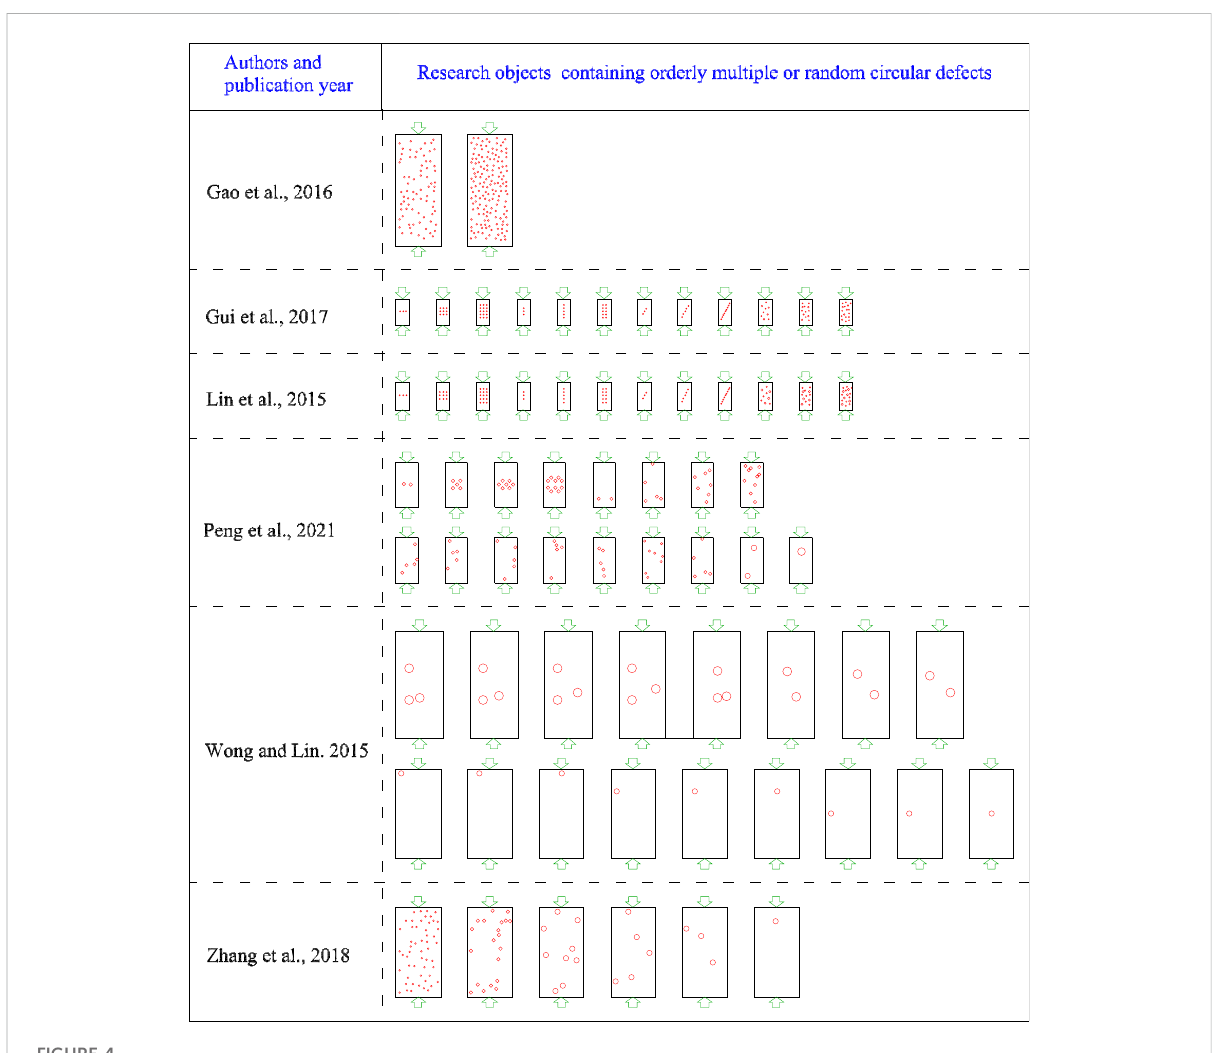
Rock or rock-like specimens containing orderly multiple defects or random